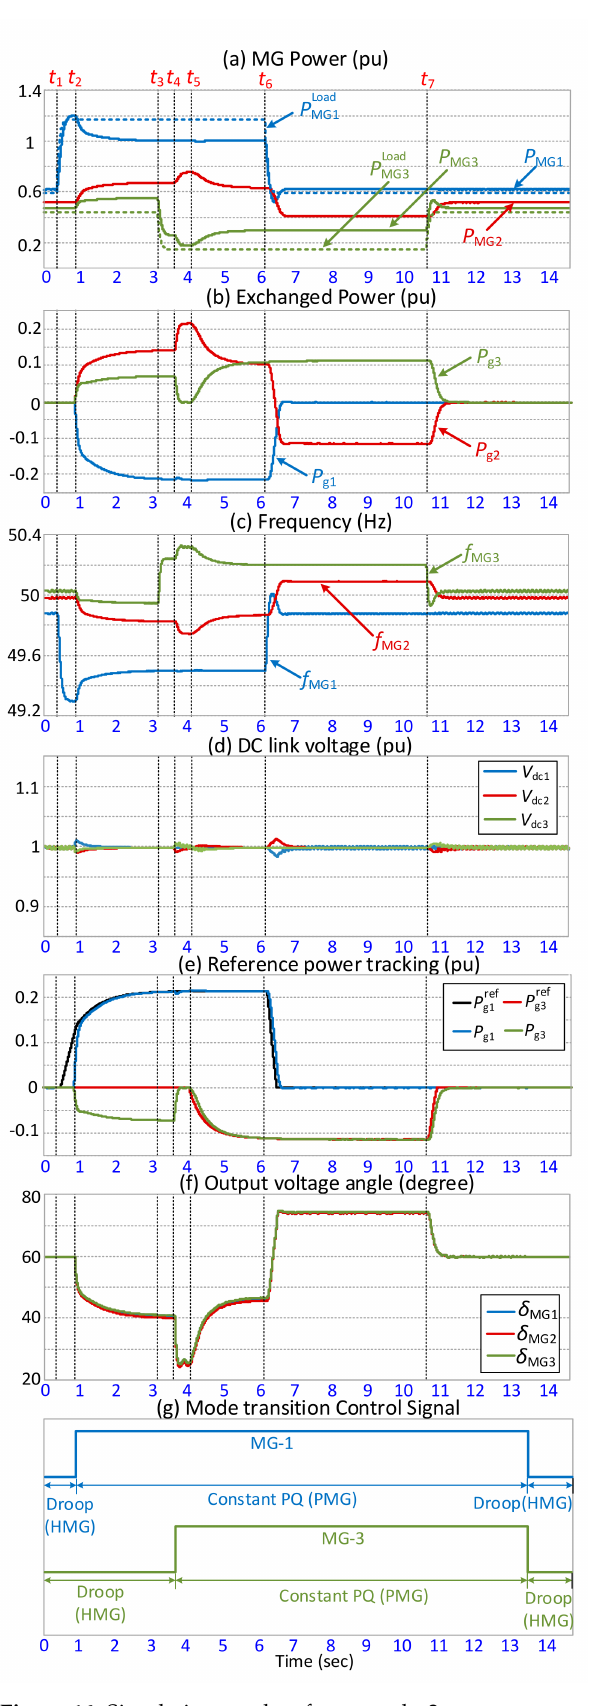
Figure 16. Simulation results of case